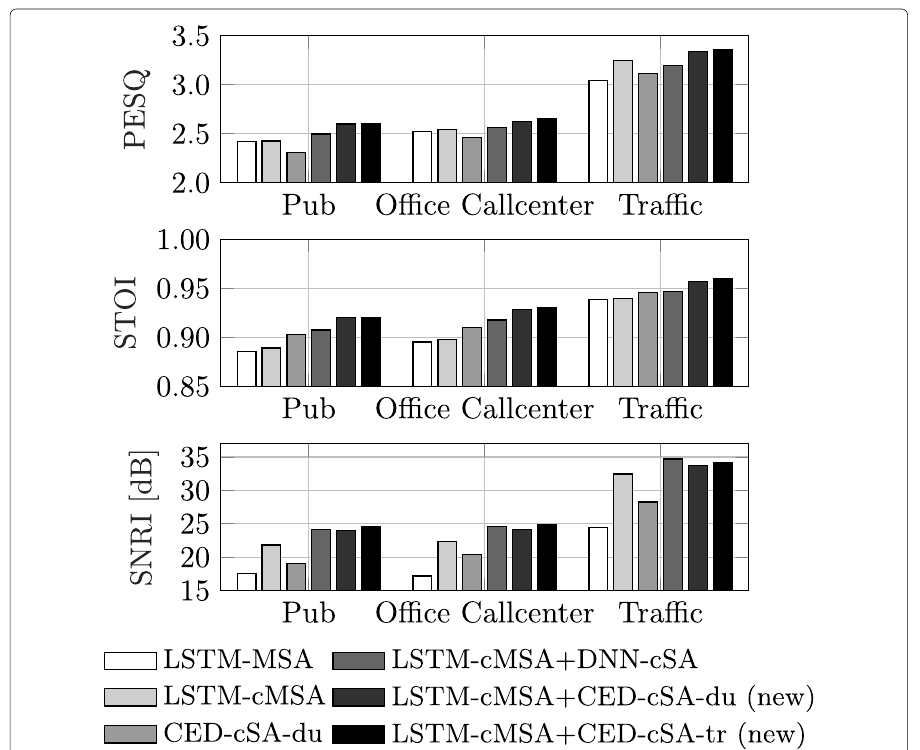
Fig. 5 Comparison of deep learning-based approaches for unseennoisetypes here also including traffic noise. Measures are PESQ, STOI, and SNRI, evaluated in the 5 dB SNR condition